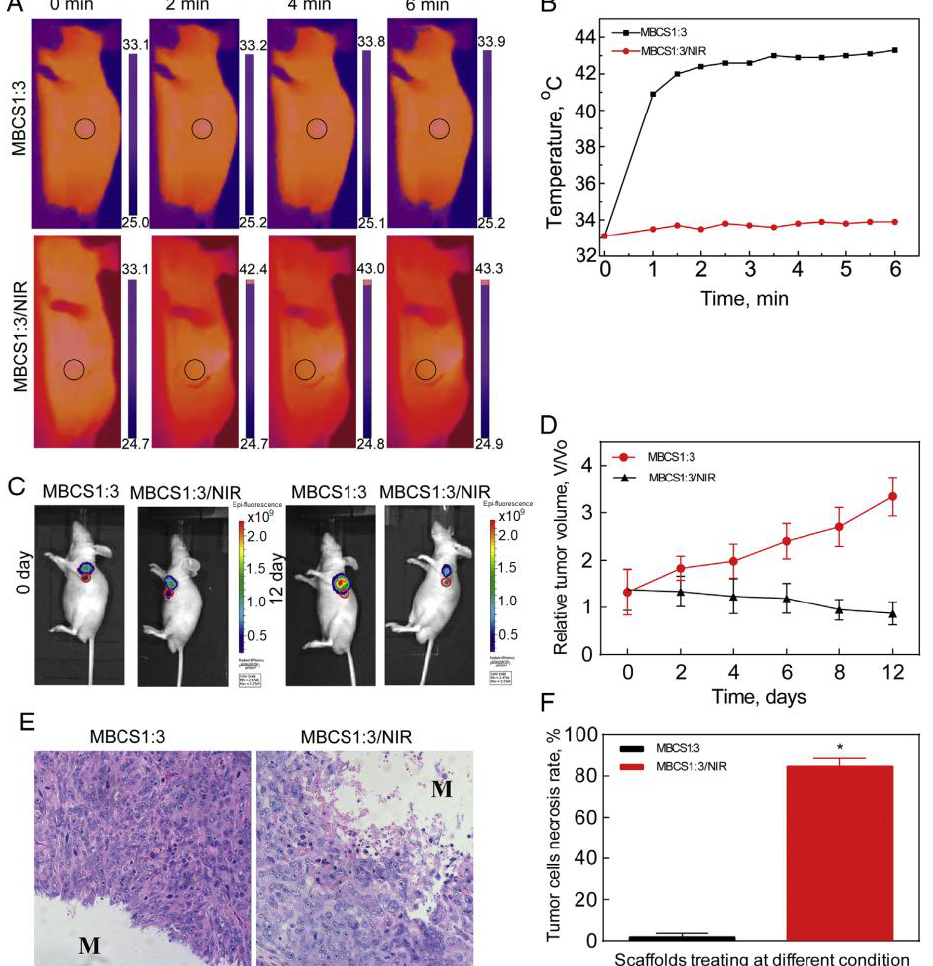
Figure 13. In vivo photothermal therapy: ( A ) infrared thermal images; ( B ) heating curves of scaffold tumor-bearing mice in the presence/absence of an NIR laser; ( C ) rodent body fluorescence images with or without NIR laser irradiation; ( D ) relative tumor volume evolution over time; ( E ) H&E stained images of tumor tissue; ( F ) tumor cell necrosis rate (* p < 0.05 versus control) [86]. Reprinted from [86], Copyright (2023), with permission from